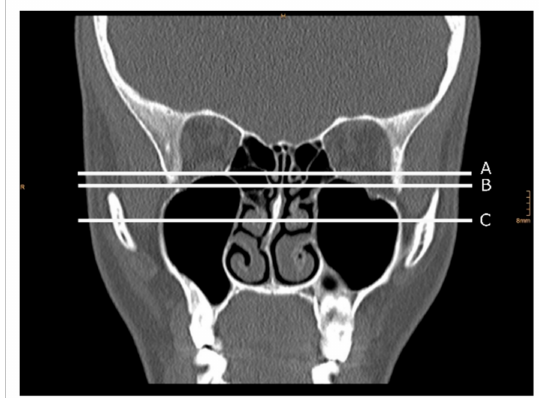
Figure 1. Caudal boundaries of the olfactory cleft (OC) used for OC-air volume analysis. The left side of the picture is the right side of the patient. (A) Horizontal line drawn 1 cm inferior to the cranial boundary. (B) Horizontal line drawn at the lower border of the superior turbinate; (C) horizontal line drawn at the head of the middle